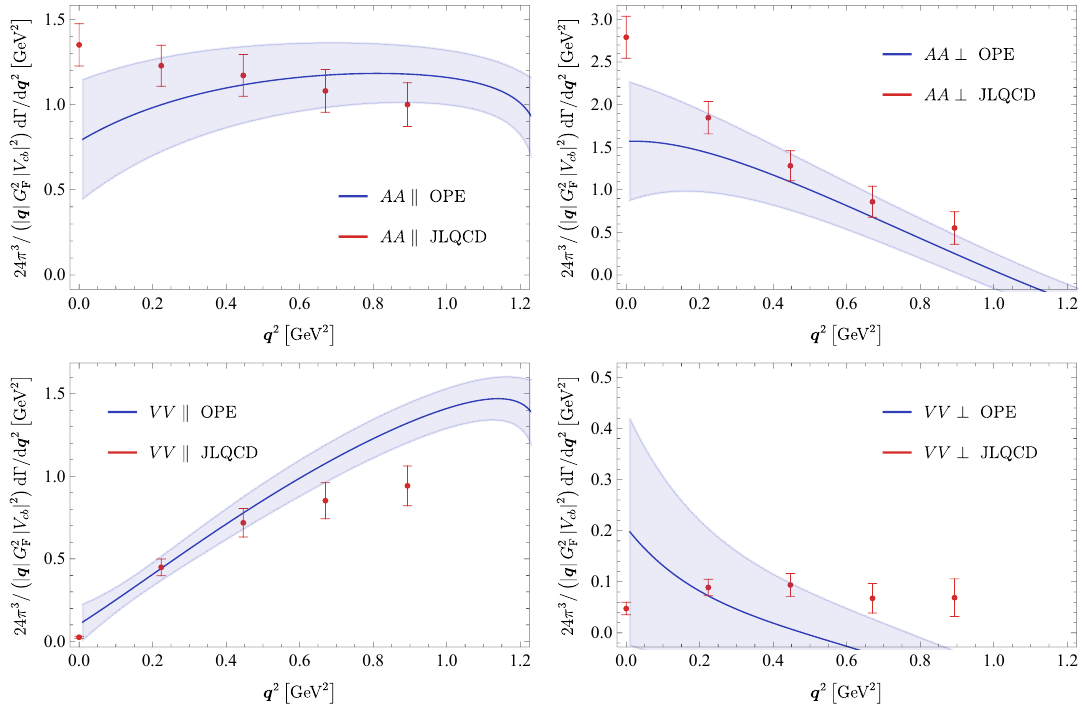
Figure 16 . Differential q 2 spectrum, divided by | q | , in the various channels. The plots show the comparison between OPE and JLQCD